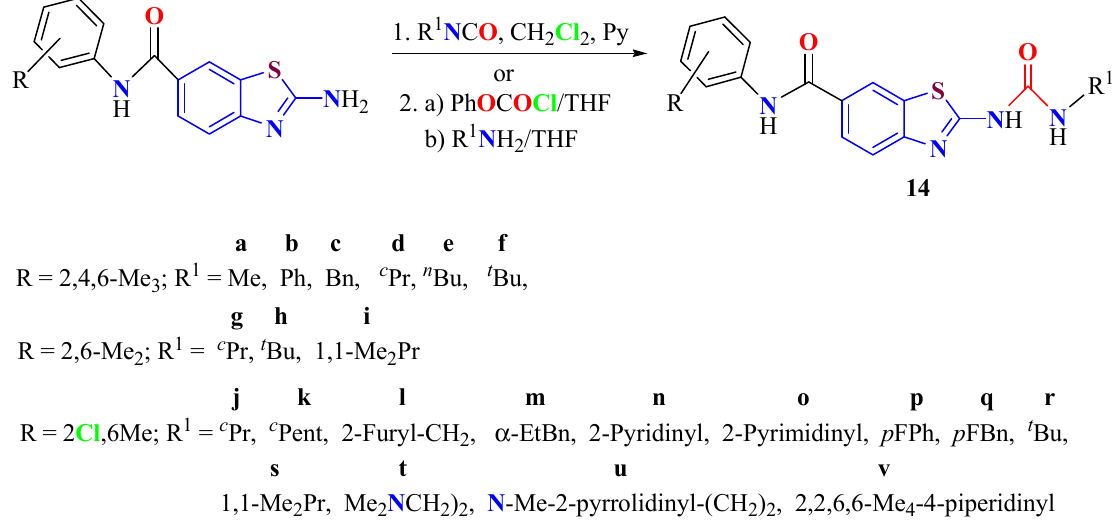
Scheme 4. Phenyl-UBT 13 from Pd catalyzed C–N coupling of BT-2-ol with phenyl urea or